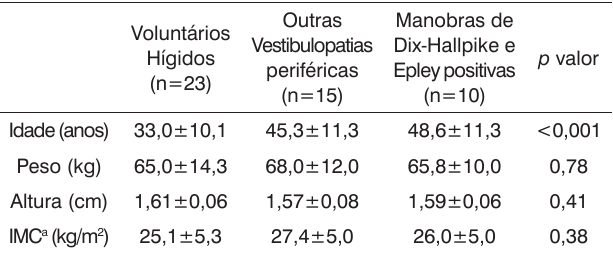
Tabela 1. Características físicas das amostras